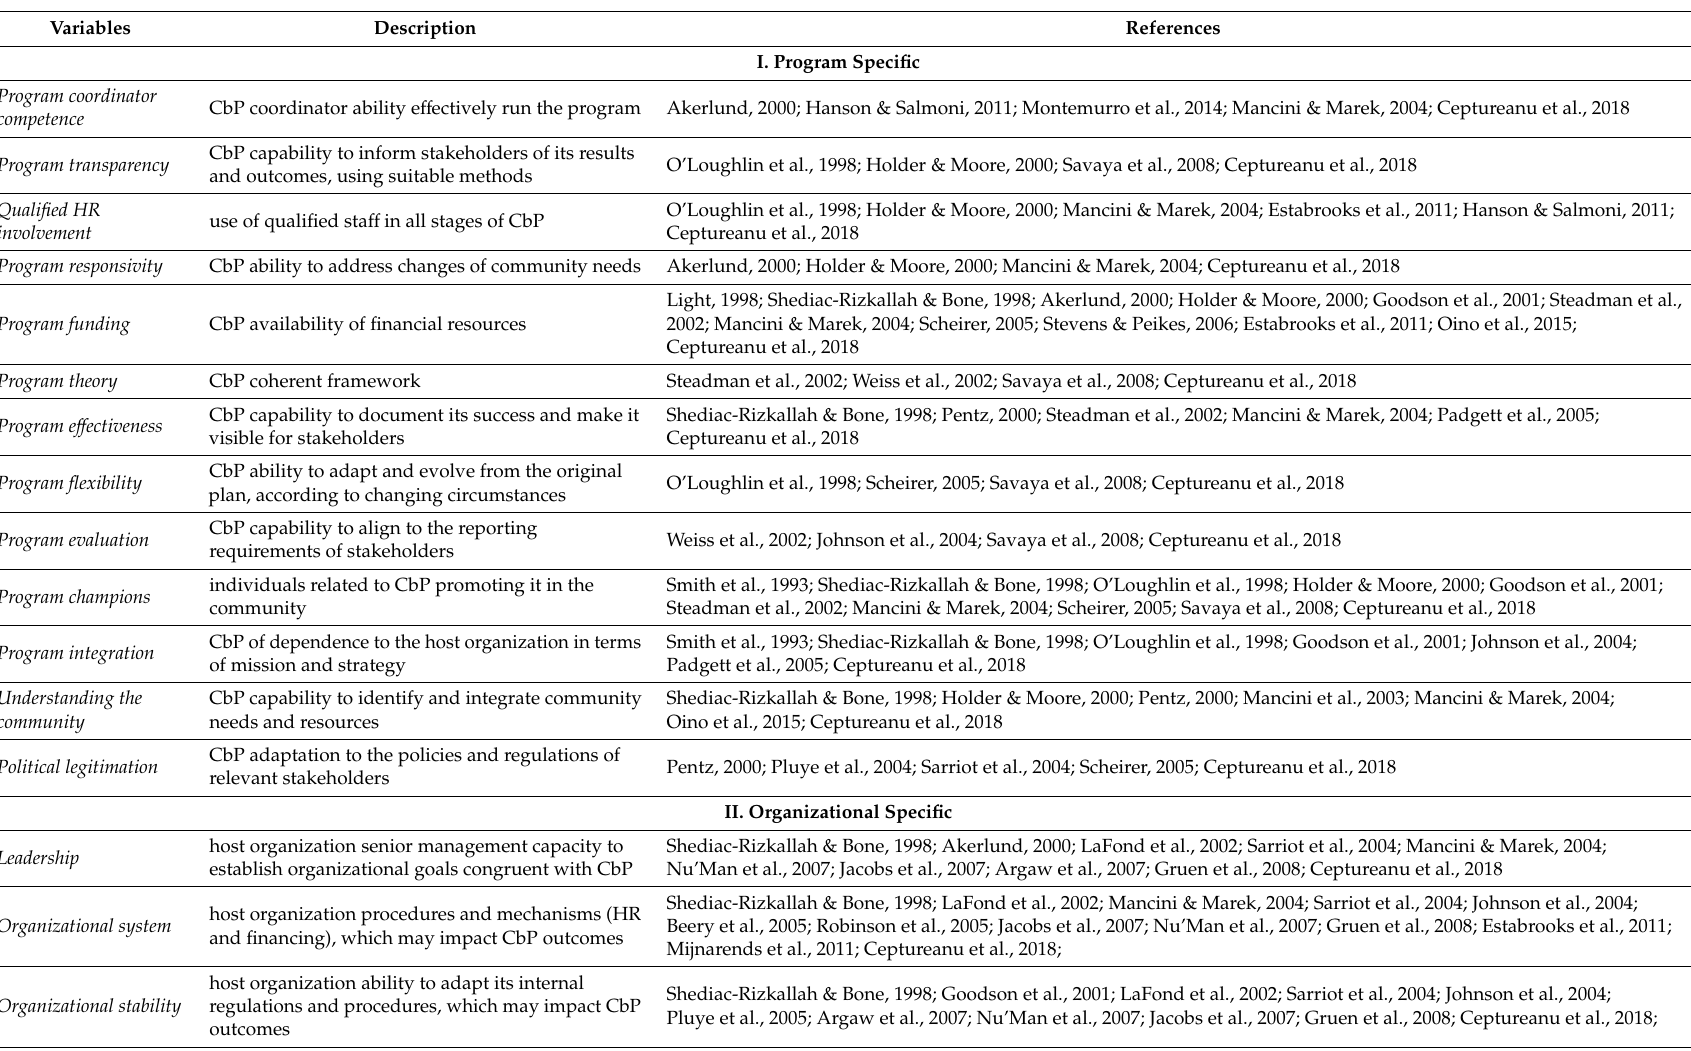
Table 1. Community-based program sustainability